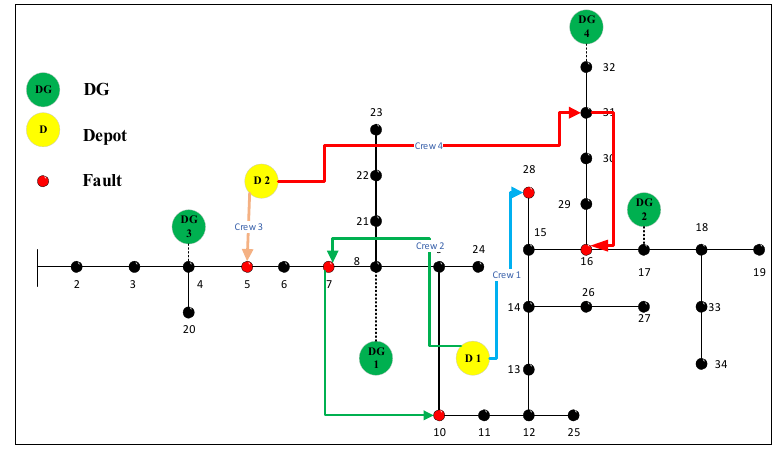
Figure 5. Sensitivity analysis on IEEE 34 bus RRC schedule.